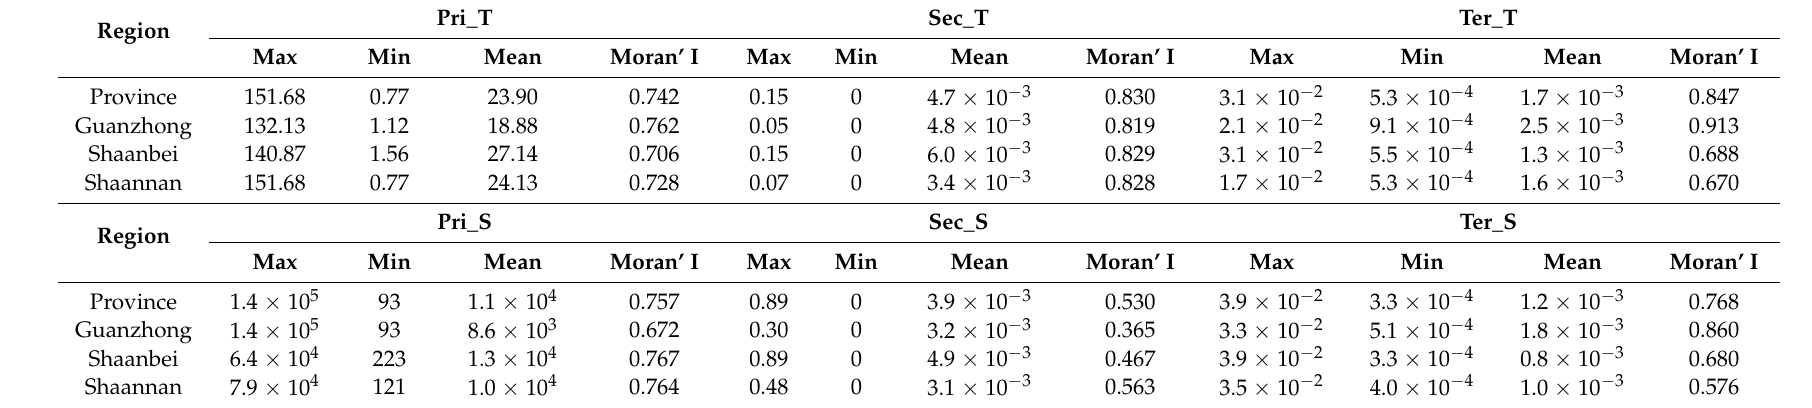
Table 1. Statistical analysis of